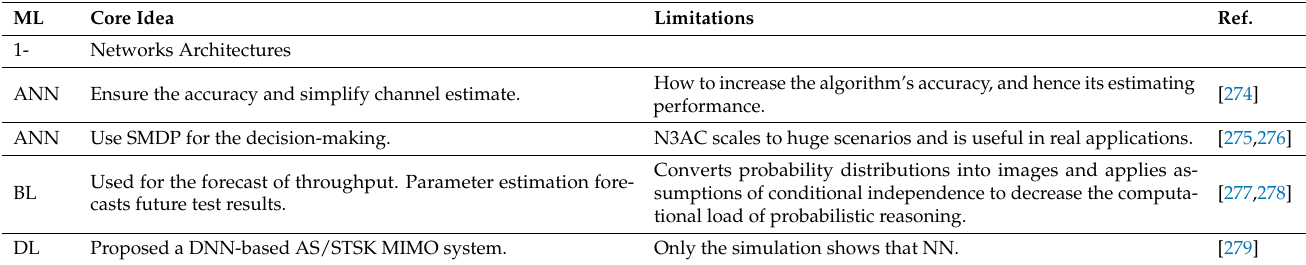
Table 6. Summary of Machine Learning-Based Schemes for 5G and 6G